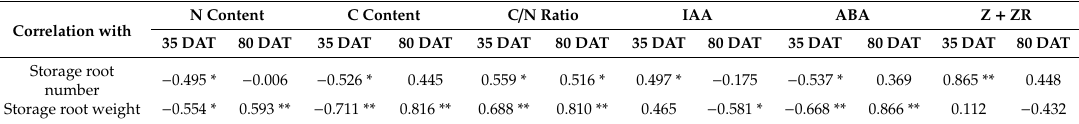
Table 1. Correlation coe ffi cients between the storage root number, mean storage root weight, N content, C content, and C / N ratio and endogenous hormone levels at two di ff erent stages after transplanting for the three N management strategies in 2016 and